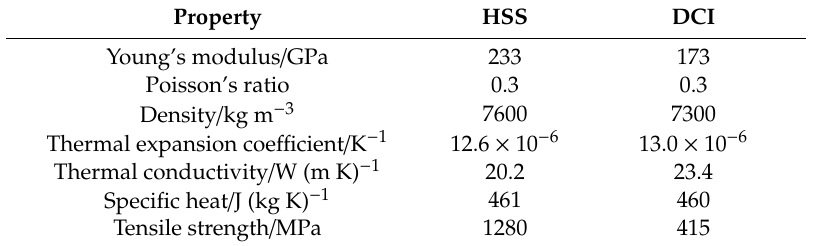
Table 2. Mechanical and thermal properties of the HSS work roll at room temperature. Property HSS DCI